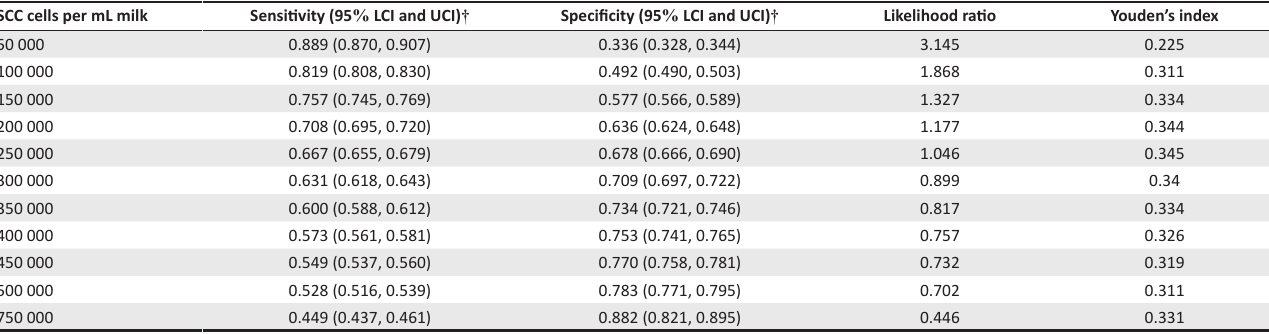
TABLE 4: Sensitivity and predictability of quarter intramammary infections for various somatic cell count thresholds. SCC cells per mL